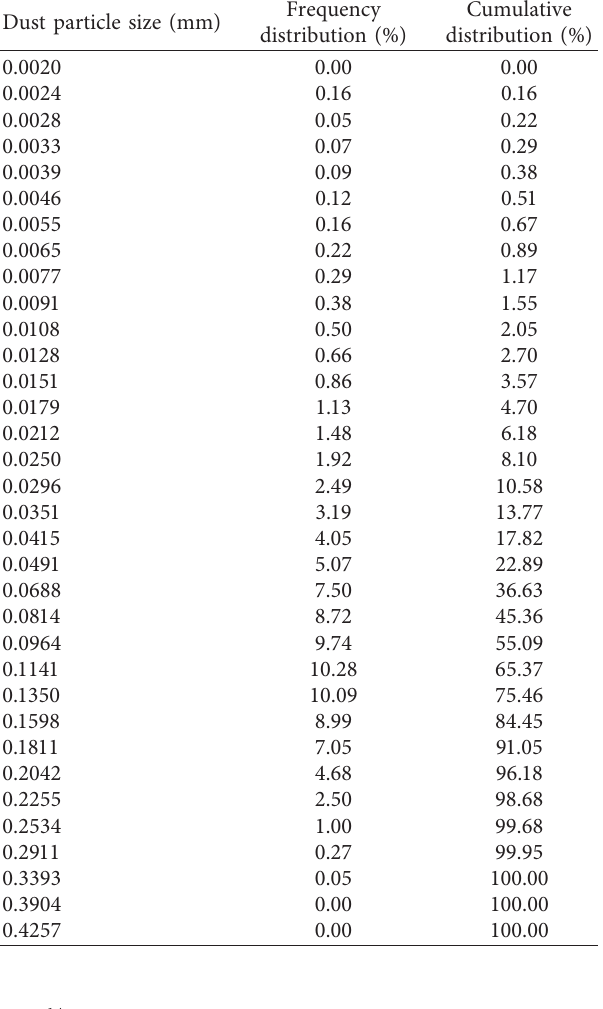
Table 3: Dust particle size frequency and cumulative distribution.